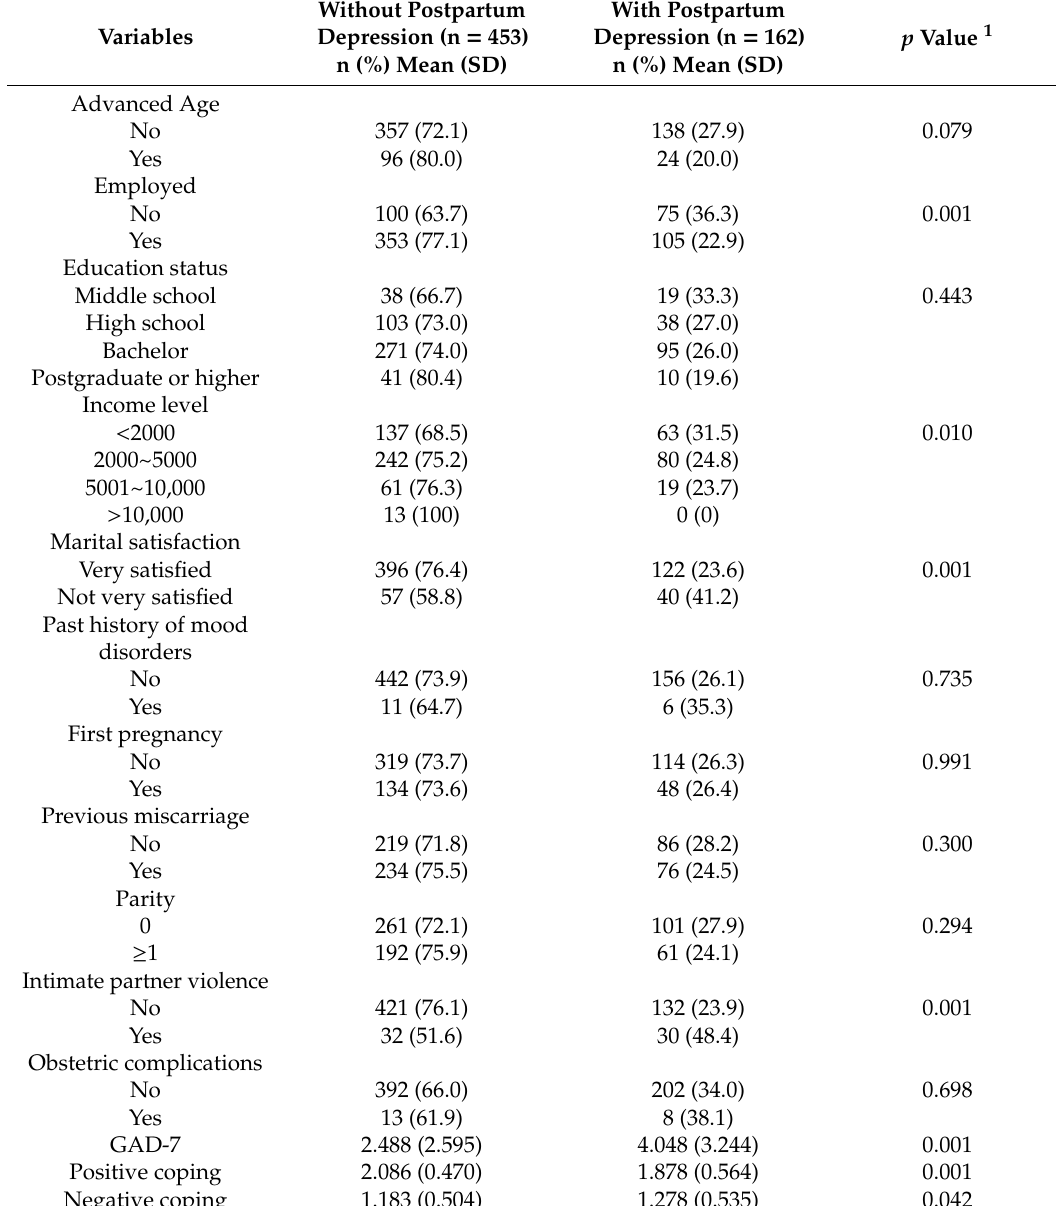
Table 5. Characteristics between women with or without postpartum